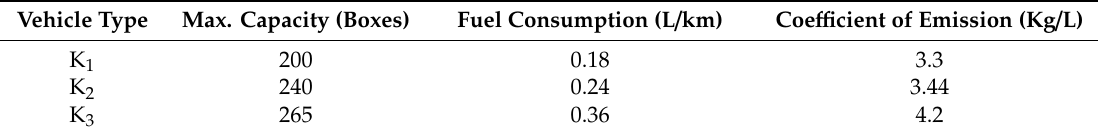
Table 7. Input values of truck related data.